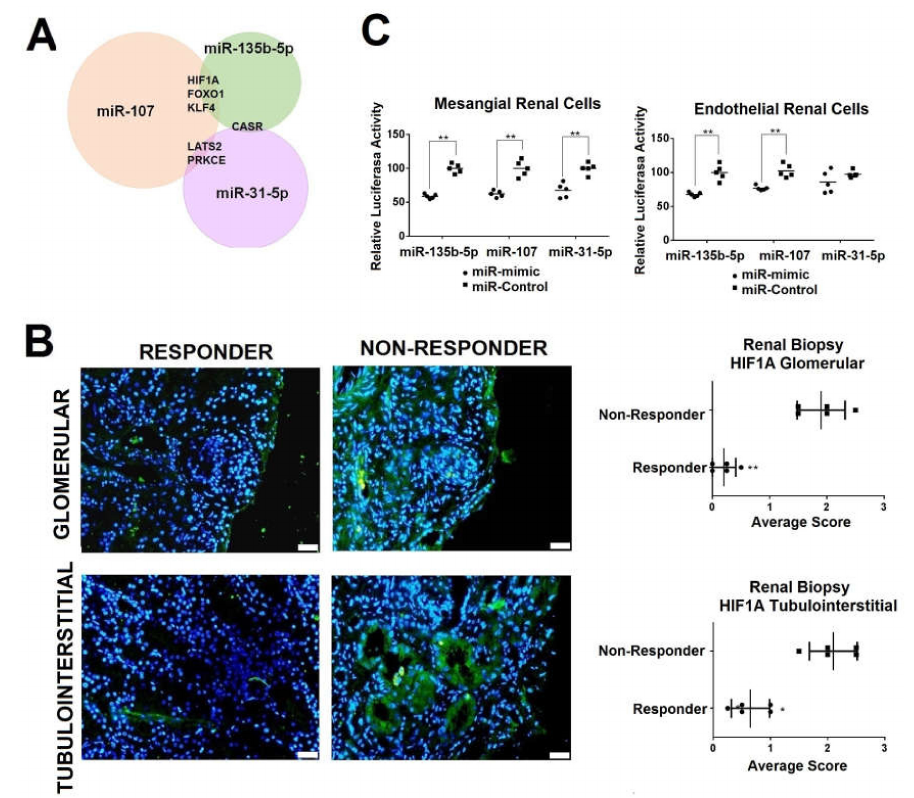
Figure 5. Urinary exosomal miRNAs specific for the LN responder group with their target mRNAs. ( A ) Venn diagram representing overlap of validated targets of miR-31-5p, miR-107, and miR-135b-5p. ( B ) Hypoxia-inducible factor-1 alpha (HIF1A) protein levels (green) in renal kidney biopsies from responder and non-responder patients. DAPI staining was used to label cell nuclei. Scale bar = 50 µ m. * p < 0.05; ** p < 0.005. ( C ) Luciferase assay showed HIF1A as common target gene for miR-31, miR-107, and miR-135b-5p in mesangial or endothelial primary renal cells (five replicates per group). p -Values were obtained using two-way ANOVA test. ** p <